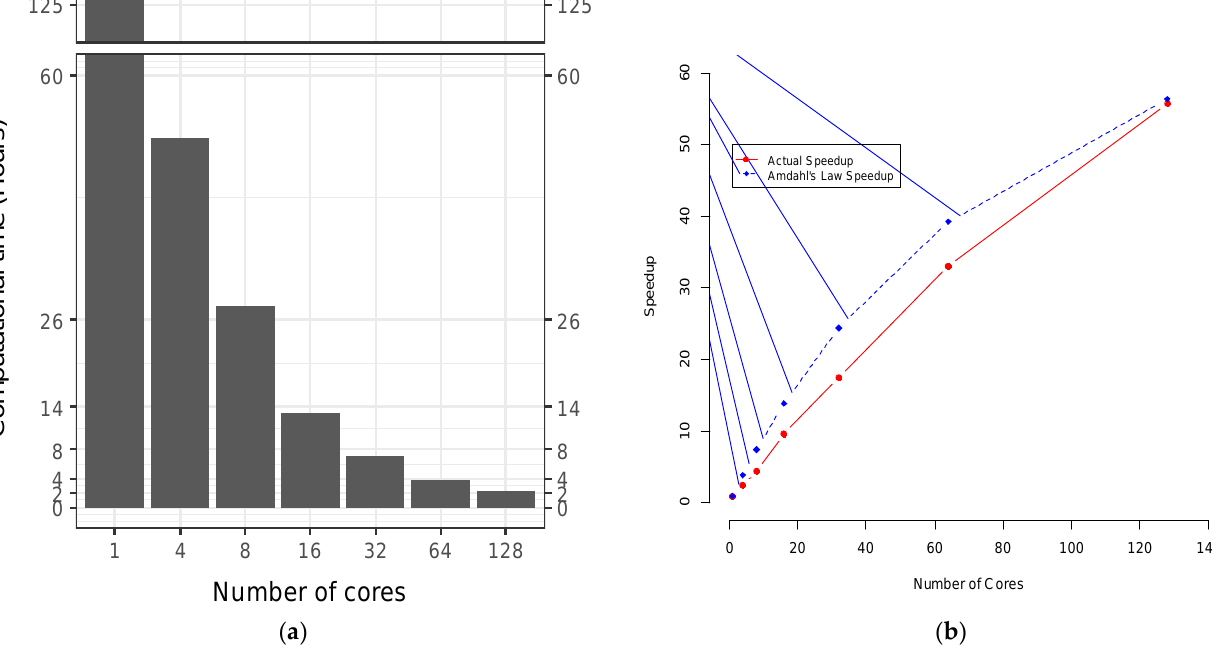
Figure 2. ( a ) Computational time vs. number of cores and ( b ) speedup vs. number of cores for imbalanced data.